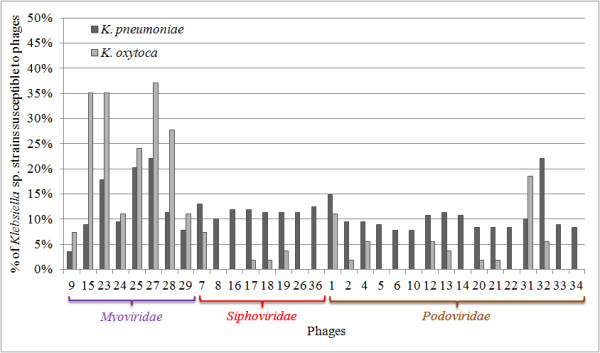
Activity of KP bacteriophages against Klebsiella sp. isolates listed in Table2.